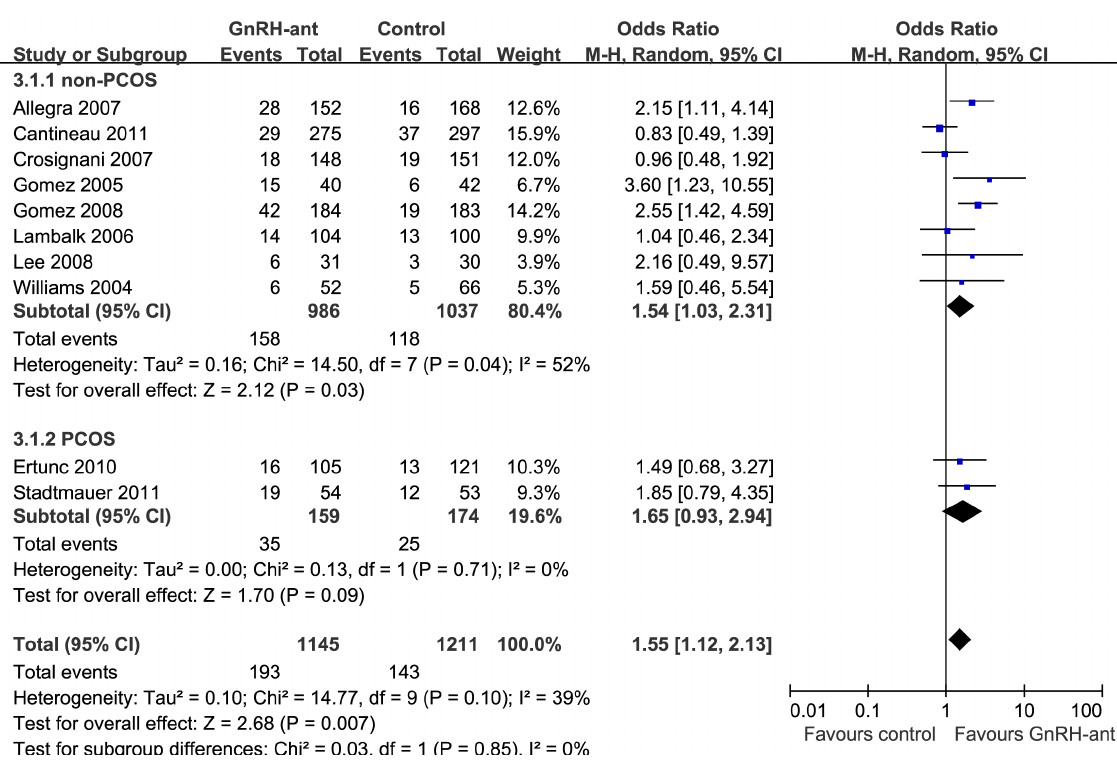
Figure 3. Subgroup analyses for the clinical pregnancy rate after GnRH antagonist administration vs. control for non-PCOS and PCOS patients.